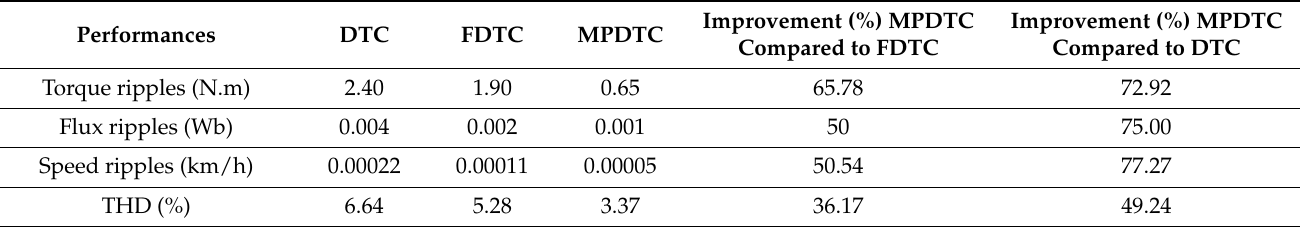
Table 7. Performances of the di ff erent control techniques in terms of torque ripples, fl ux ripples, speed ripples and THD.